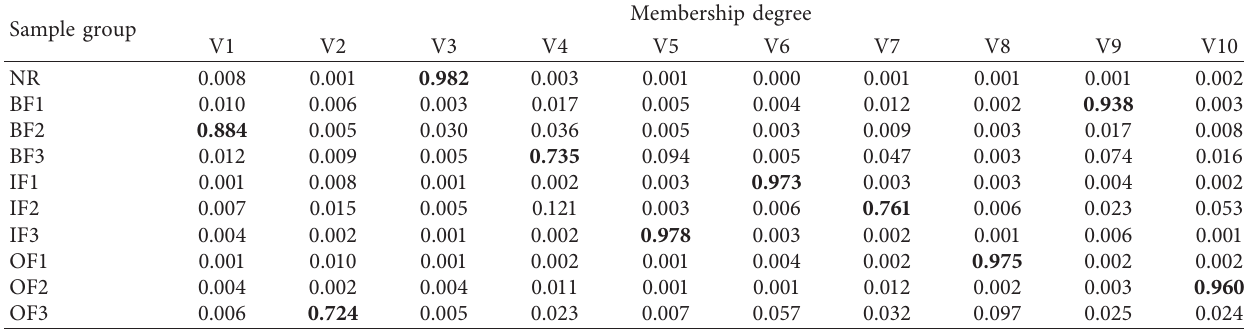
Table 4: Membership degrees of 10 types of signals.